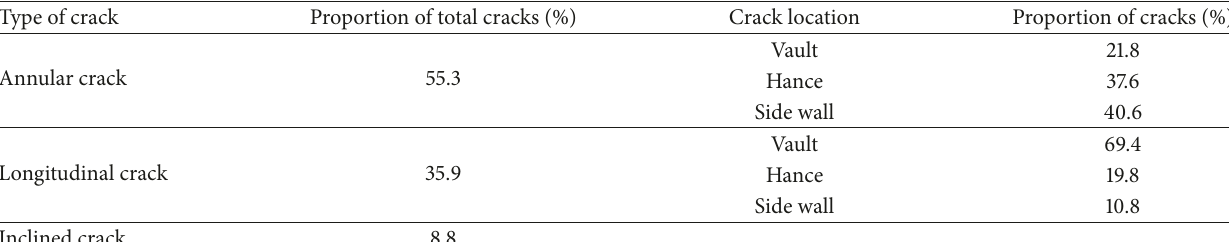
Table 2: Spatial distribution statistics of cracks with different extension directions.